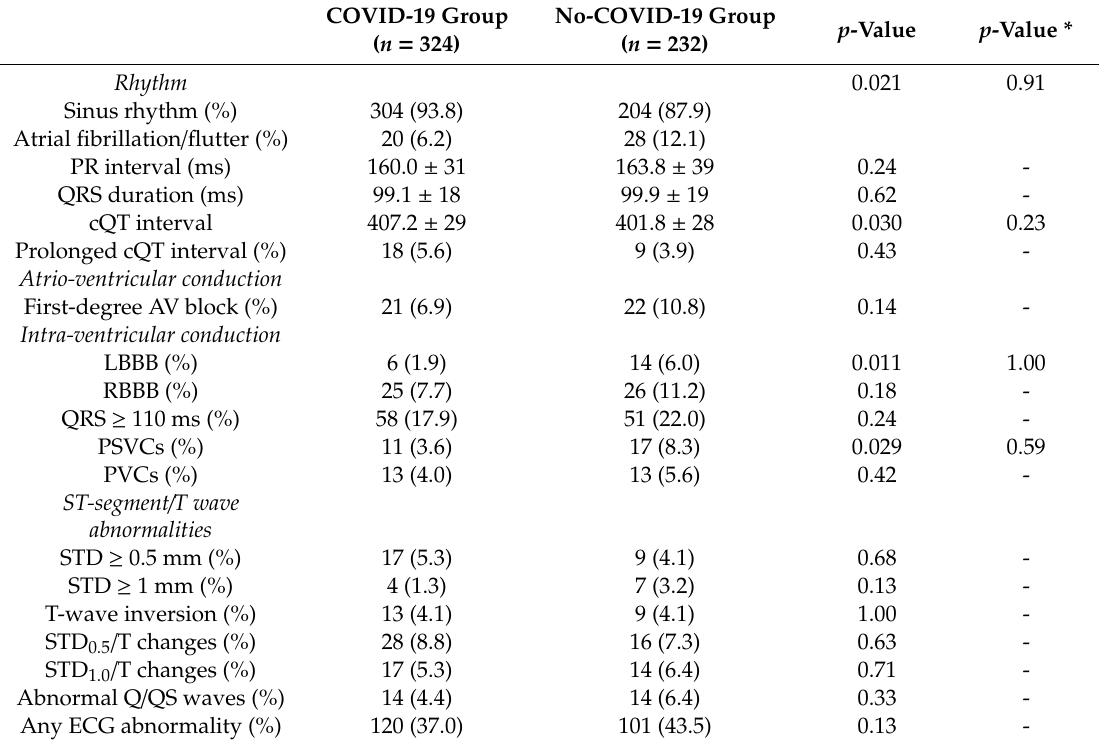
Table 2. Main ECG findings of COVID-19 and no-COVID-19 patients.